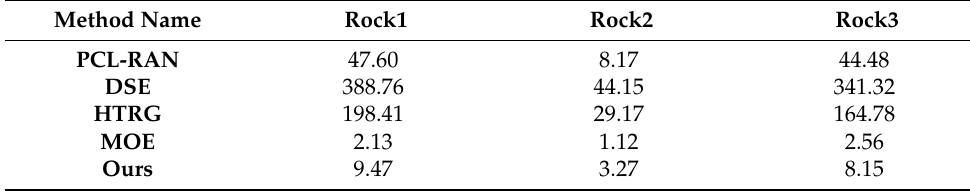
Table 4. Execution time for different rocks